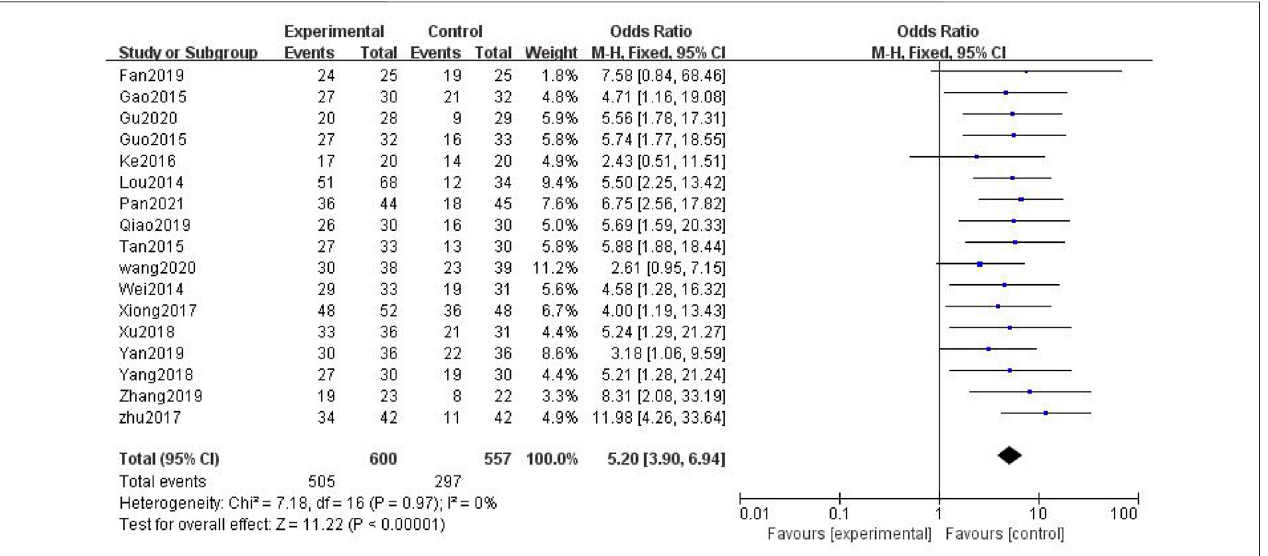
CIPN is characterized by limb pain and numbness, which is referred to as “ Bi syndrome ” in TCM. Chemotherapeutic drugs